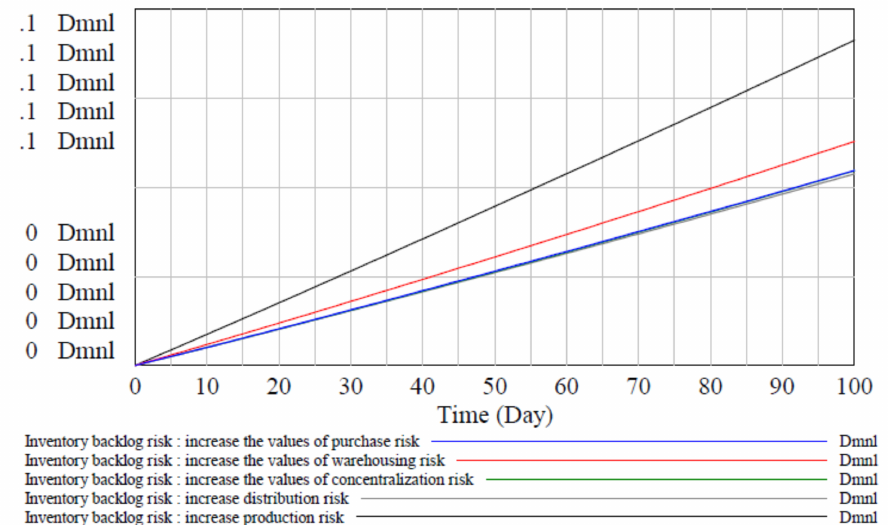
Figure 9. Comparison of inventory backlog risk when only one kind of risk